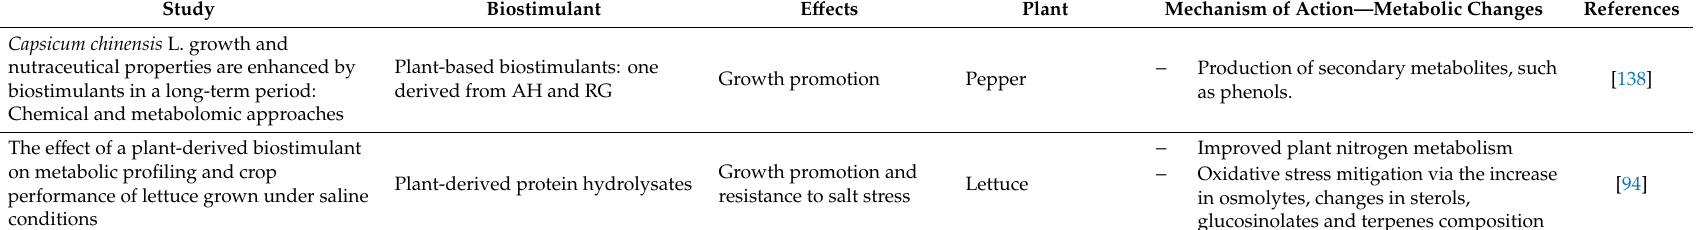
Table 2. Some applications of metabolomics in elucidating mechanisms and modes of action of plant